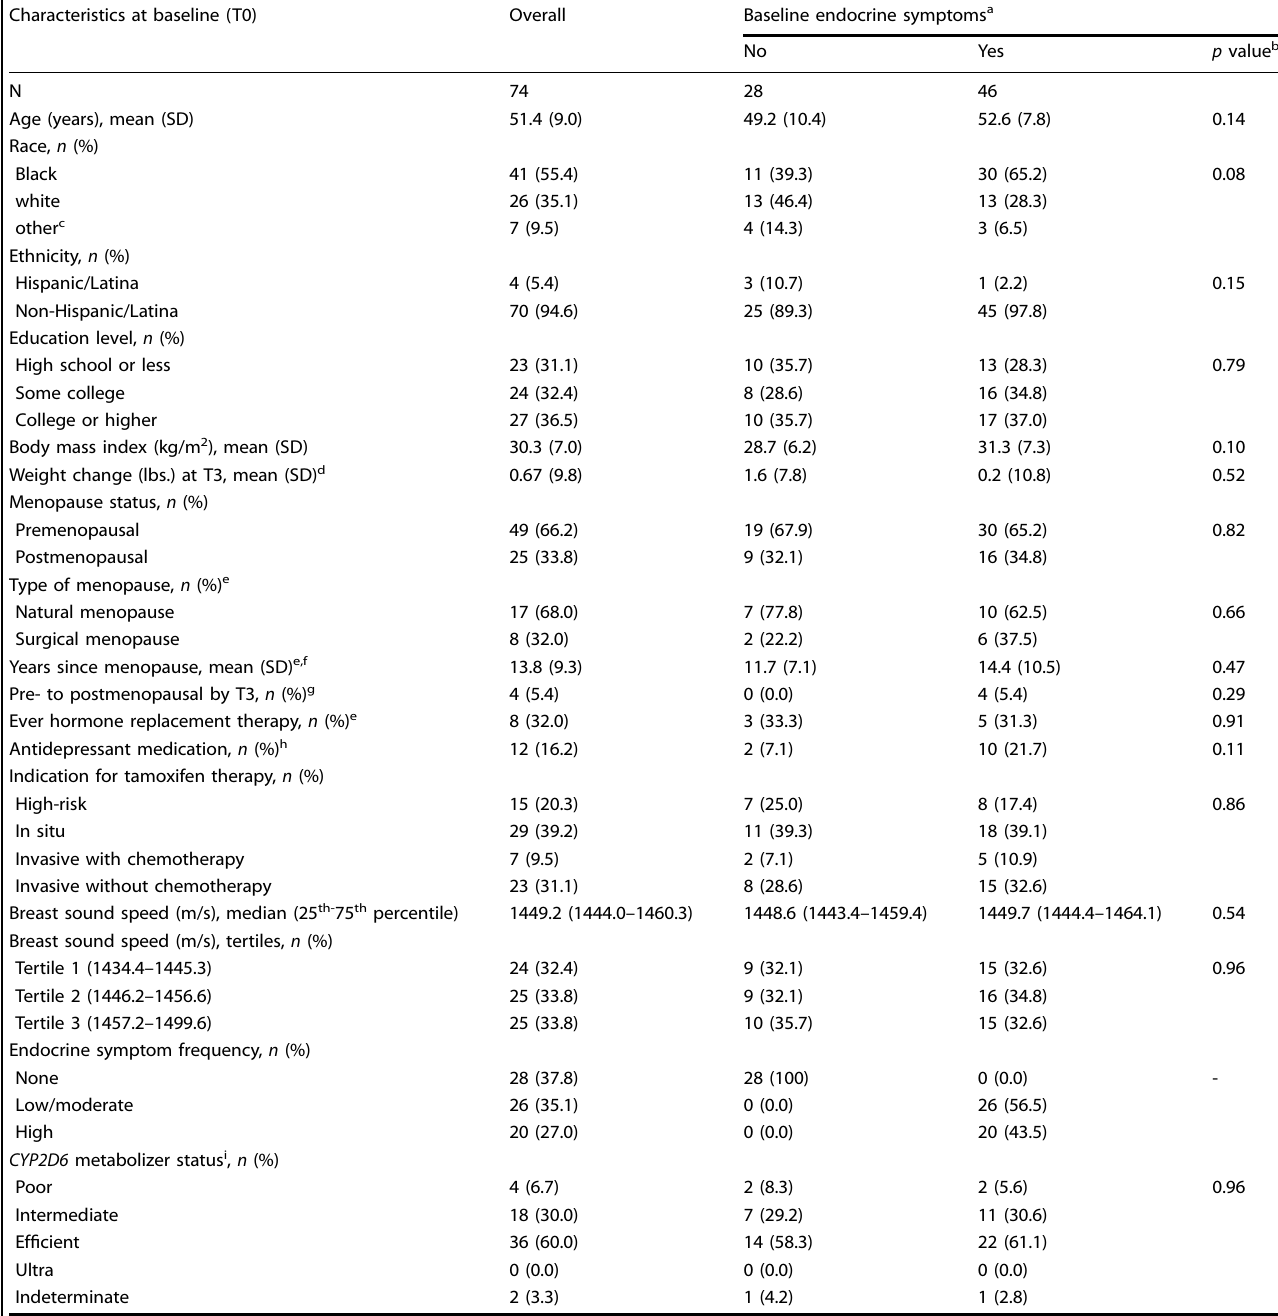
Table 1. Characteristics of women treated with tamoxifen in the Ultrasound Study of Tamoxifen. Characteristics at baseline